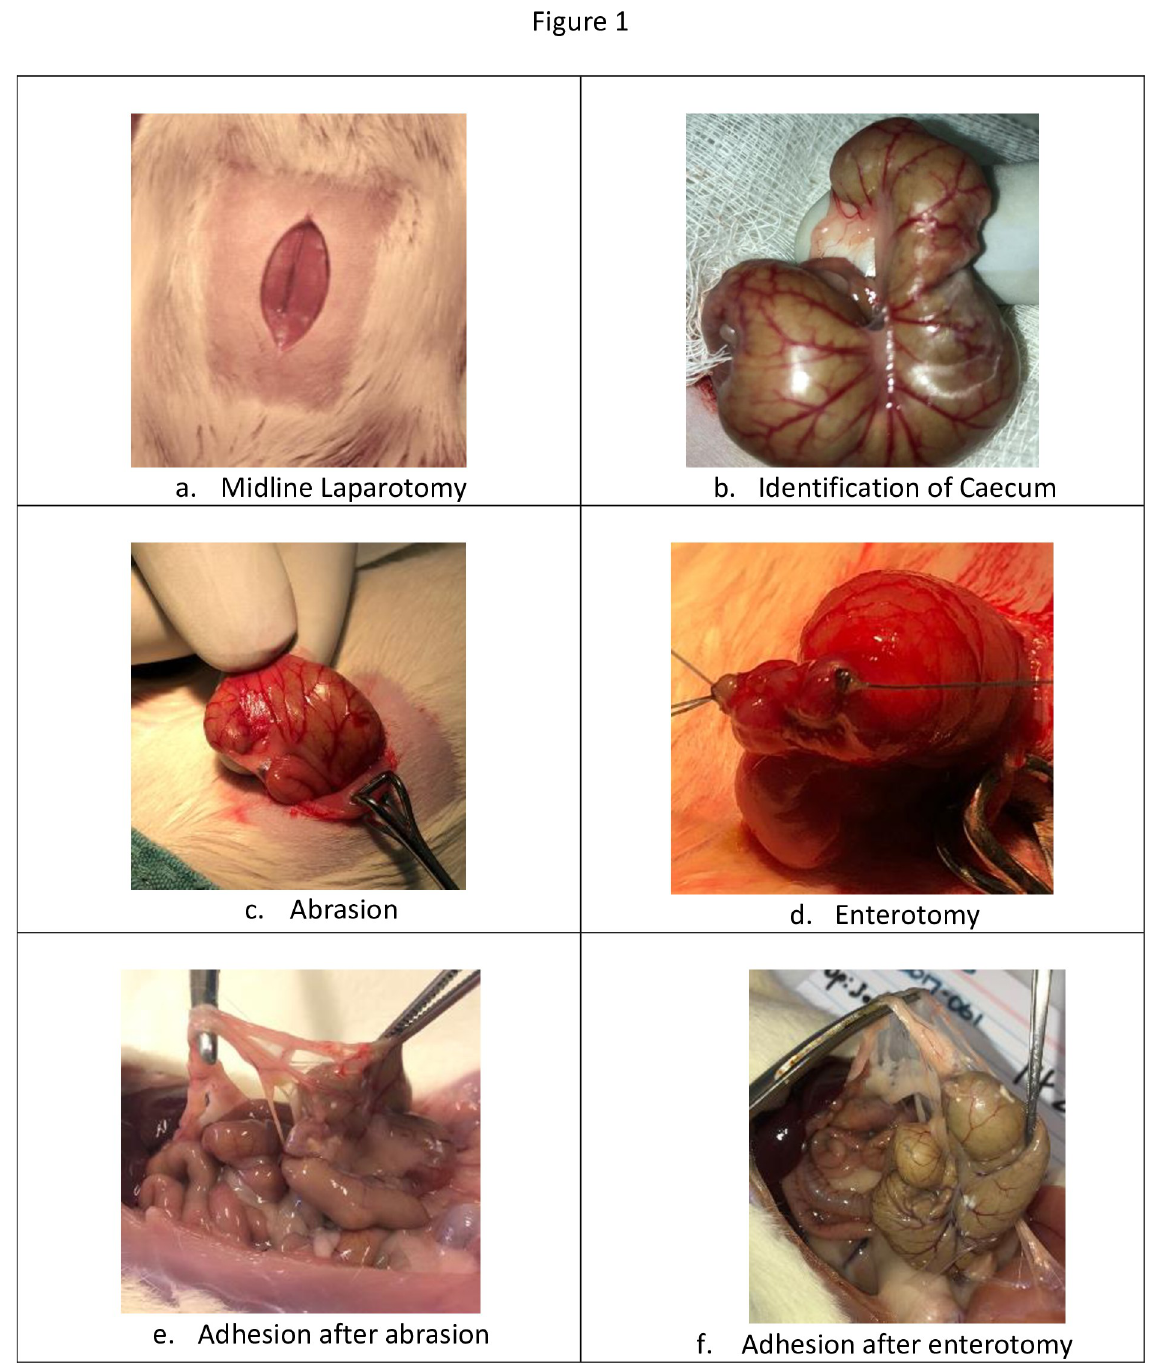
Fig 1. a. Incision over the Rat abdominal wall after preparation, (orange arrow) b. Identification of Caecum, c. Abrasion over the caecum with gauze till bleeding spots appear, d. Enterotomy sutured, e. Adhesion induced by Kaolin at dosage of 0.005g/ml at day 21, f. Adhesion over the enterotomy site at day